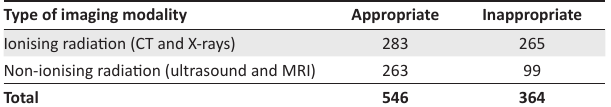
TABLE 2: A comparison of the appropriateness of imaging choice of ionising and non-ionising